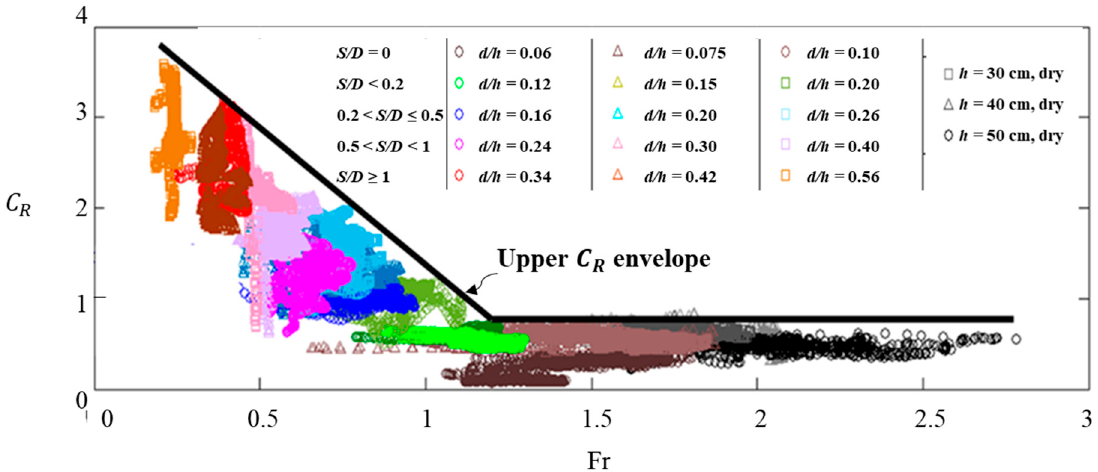
Figure 10. Calculated resistance coefficients versus Froude numbers for all the experimental cases tested in this study. J. Mar. Sci. Eng. 2019 , 7 , 262